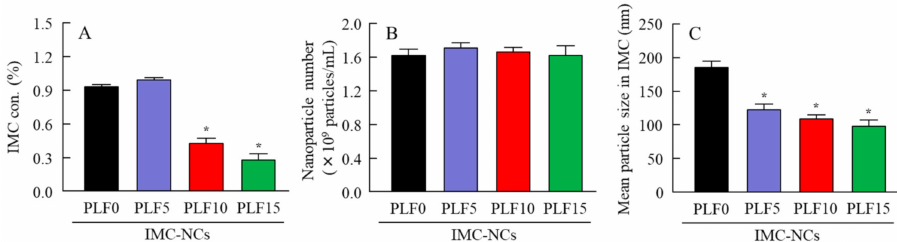
Figure 3. Dispersibility, nanoparticle number, and size of IMC in IMC-NPs, IMC-NC / PLF5, IMC-NC / PLF10, and IMC-NC / PLF15 one month after the preparation. Ophthalmic IMC-NC formulations stored at 20 ◦ C for one month. ( A ) IMC concentration at 5 mm under surface of each ophthalmic IMC-NC formulation stored for one month (dispersibility). IMC ( B ) nanoparticle number and ( C ) size in each ophthalmic IMC-NC formulation one month after preparation. ( B , C ) Ophthalmic IMC-NC formulations were gently stirred before measurement. Compositions of each ophthalmic IMC-NC formulation shown in Table 1; n = 5; * p < 0.05 vs. PLF0 (IMC-NPs) for each category. For IMC-NPs and IMC-NC / PLF5, IMC-NCs were evenly dispersed throughout, although in IMC-NC / PLF10 and IMC-NC / PLF15, the upper layer was poor in IMC-NCs and the lower layer was rich in IMC-NCs at one month after preparation. On the other hand, PLF-127 enhanced the stability of